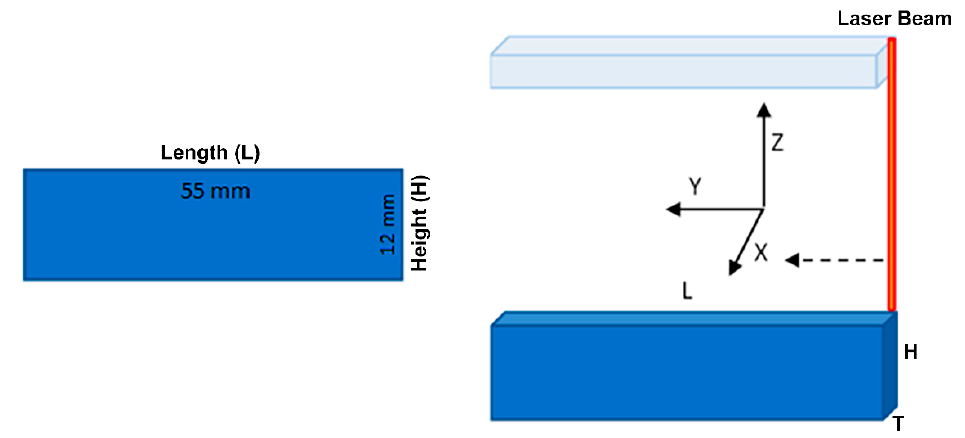
Figure 2. Samples dimensions and built-up scheme.